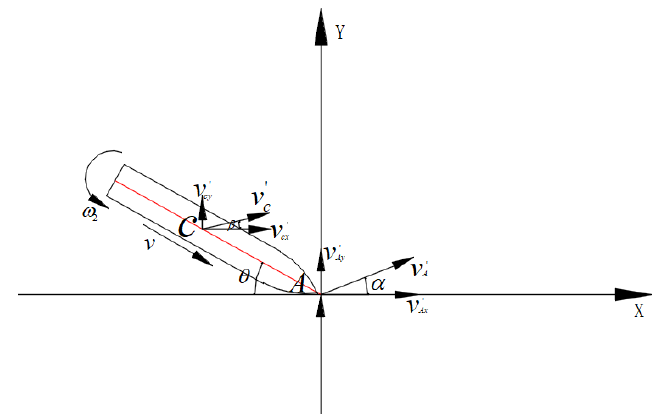
Figure 2. Momentum analysis in terms of the first impacting.